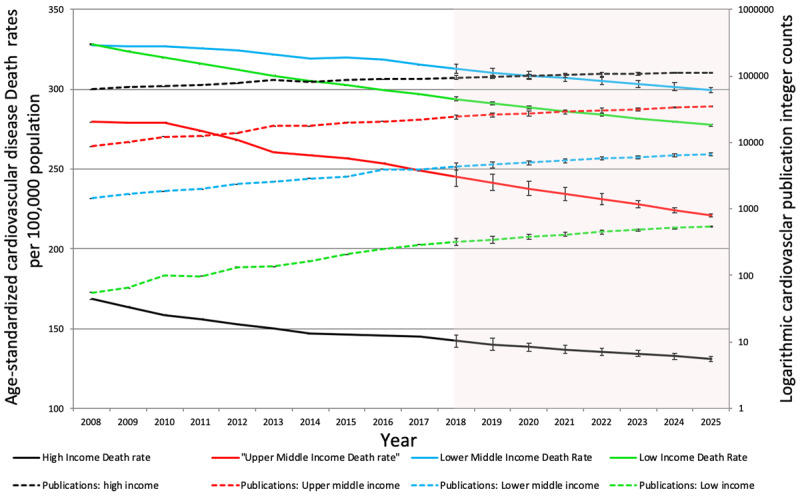
Trends in integer counts of cardiovascular publications and age-standardized death rates of cardiovascular disease in World Bank income groups (2008–2017).Shadowed portion represents forecasted values.